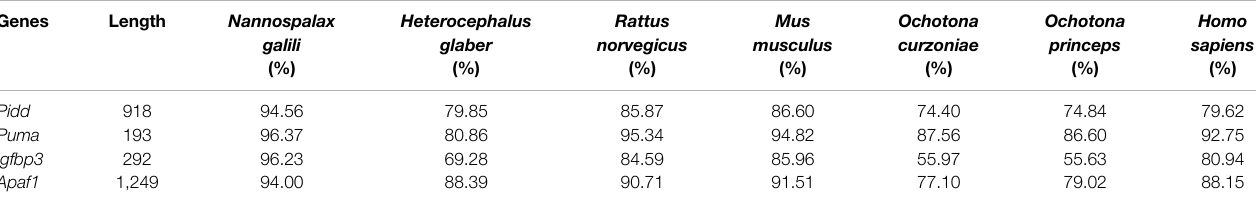
TABLE 2 | Amino acid sequence homology of apoptosis-related genes between plateau zokor and other species. Genes